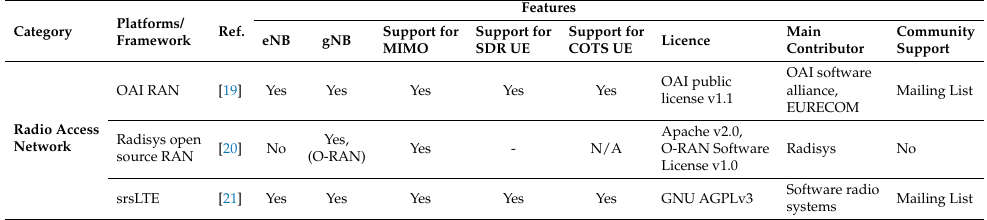
Table 1. Comparison of Radio Access Network Platforms.